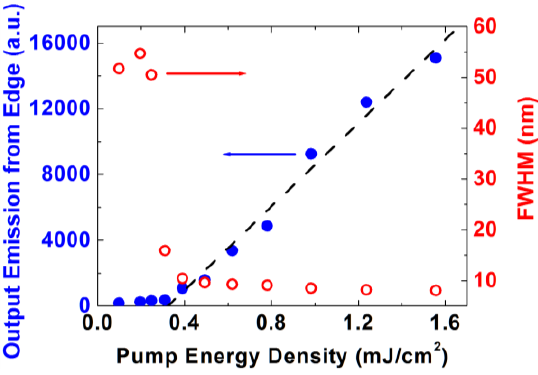
Figure 5. The edge emission intensity from a PIM-1 planar waveguide as well as the dependence of the FWHM of the emission spectra versus pump energy